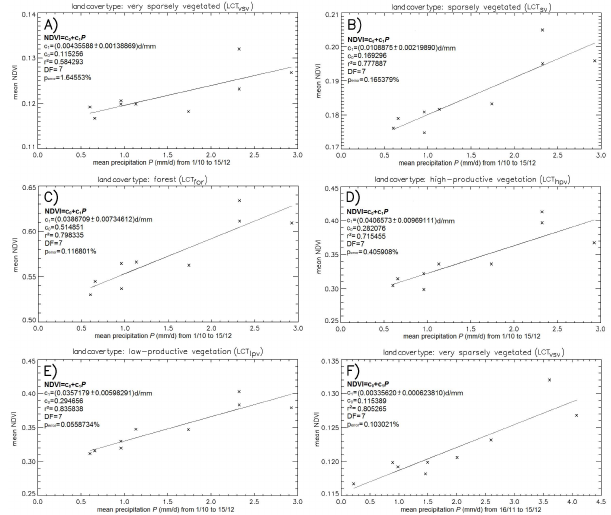
Fig. 13. Correlation of mean daily precipitation and NDVI (per- centile 50%) of stably classified areas. Best fit for a common time period (A–E) and best individual fit (F) for land cover type very sparsely vegetated (LCT vsv ) . DF = Degrees of